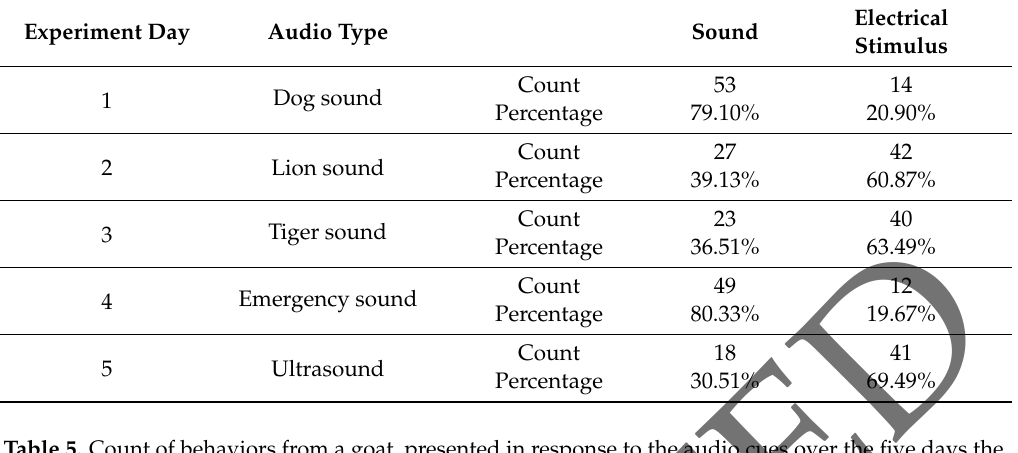
Table 4. Contingency table of the number of times the electrical stimulus was or was not applied to the goat, following an audio cue during the stimuli tests.